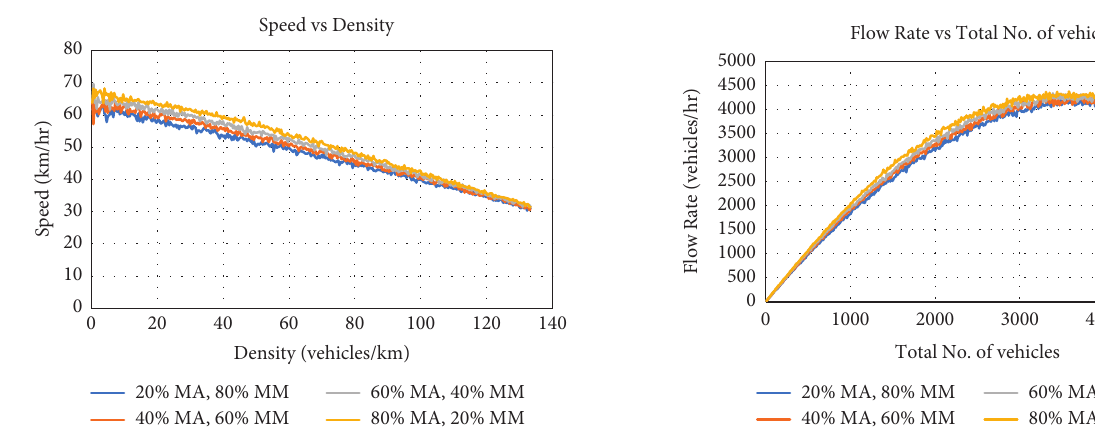
Figure 27: Speed vs. density fundamental diagrams for different compositions of MA and MM.